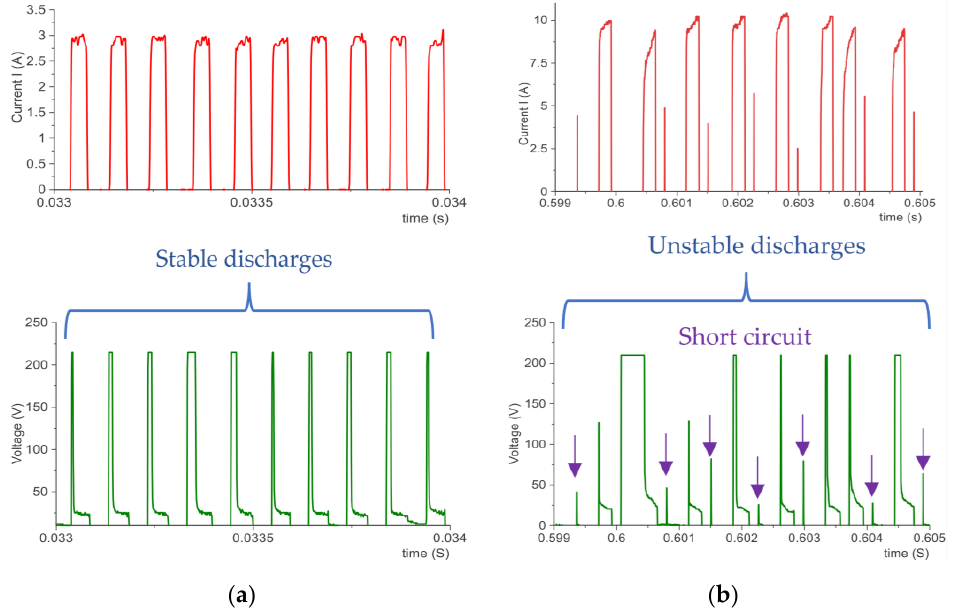
Figure 2. Current and voltage waveforms recorded during EDM for ( a ) stable and ( b ) unstable machining parameters.